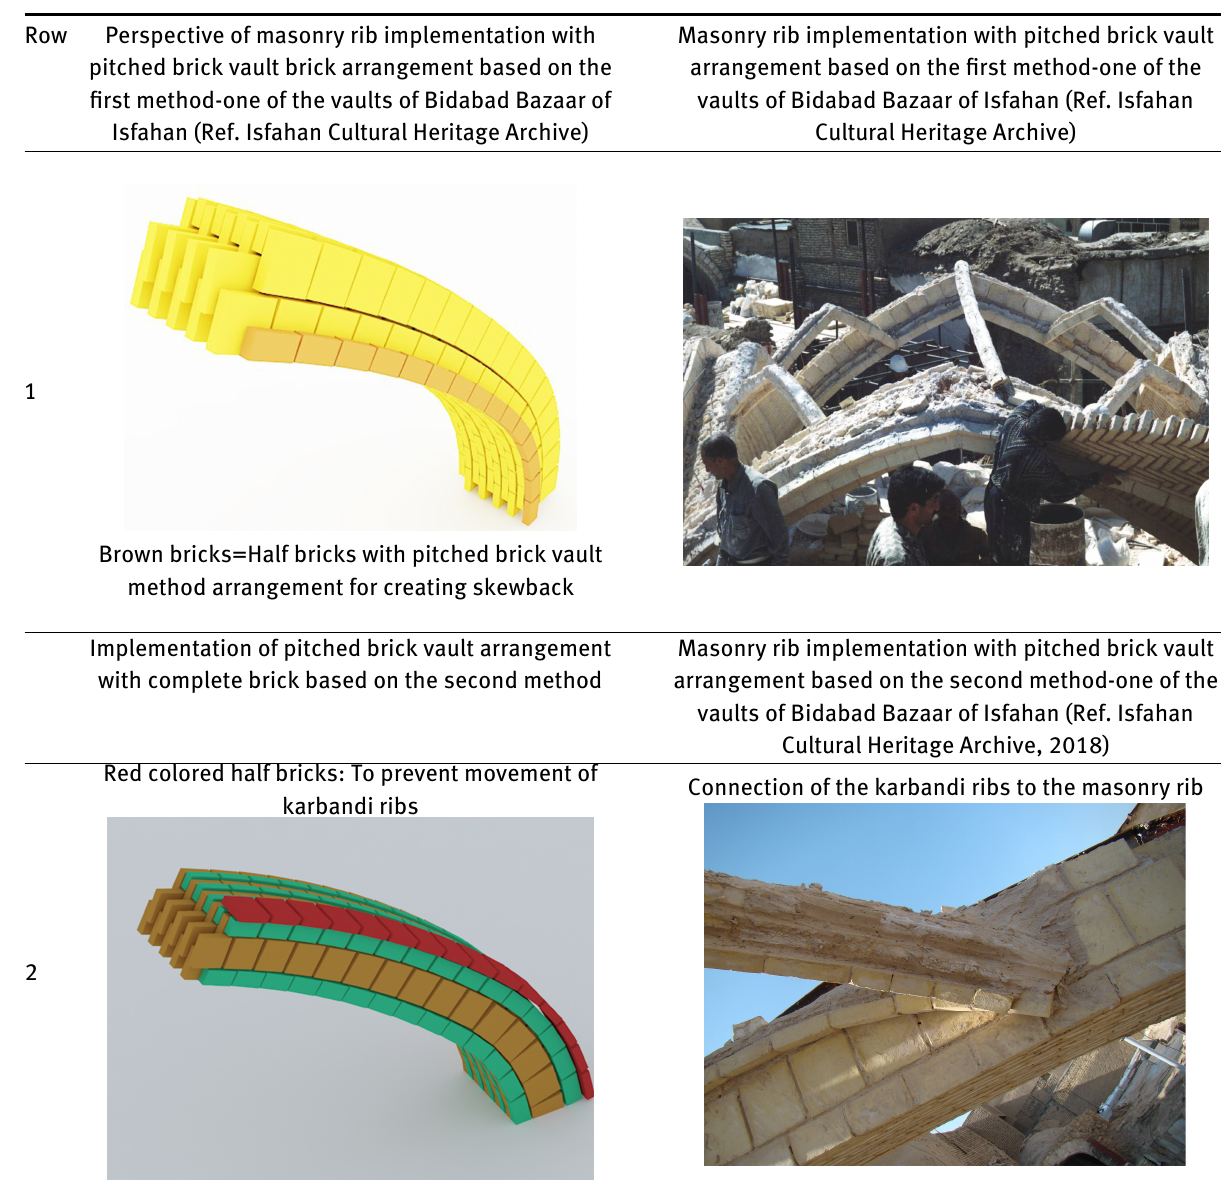
Table 3: Perspective and photo of some examples of masonry rib implementation method with pitched brick vault brick arrangement